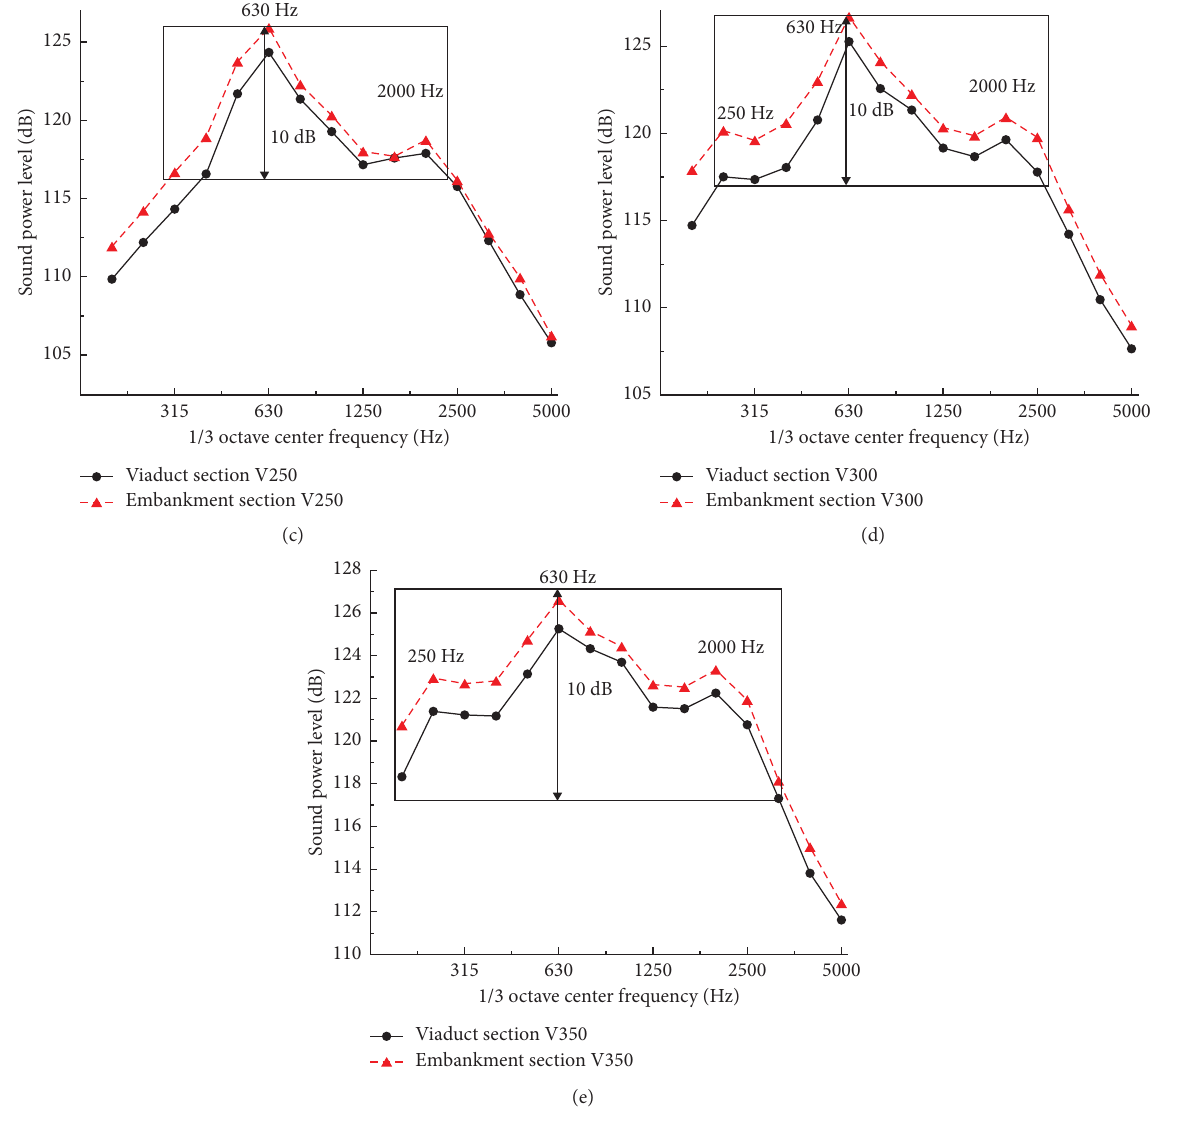
Figure 8: Spectrum of the sound power level of the train running in the viaduct and embankment sections at different speeds. (a) Sound power level spectrum at 160km/h. (b) Sound power level spectrum at 200km/h. (c) Sound power level spectrum at 250km/h. (d) Sound power level spectrum at 300km/h. (e) Sound power level spectrum at